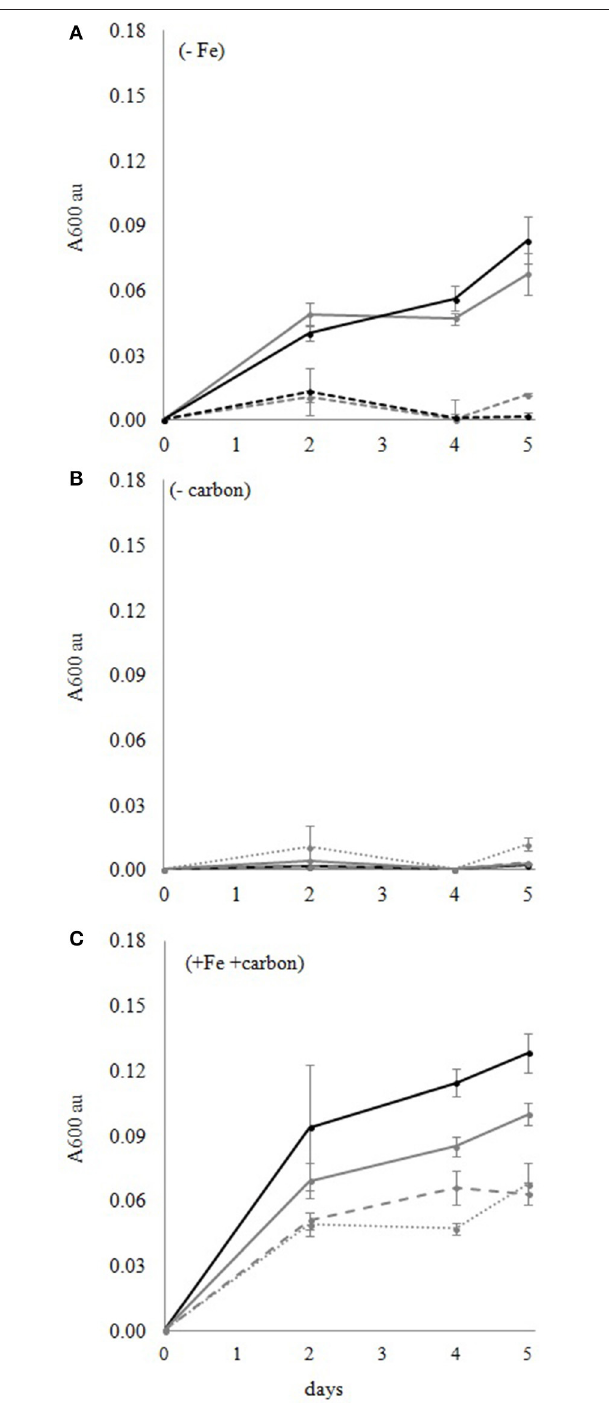
FIGURE 1 | DG893 growth in media with and without Fe and carbon. (A) DG893 growth in media without added Fe. The bold lines represent media containing 10 mg/mL Casamino Acids. The dotted lines represent media without Casamino Acids. The gray lines represent L1-Fe media. The black lines represent seawater. The VF null mutant of DG893 showed a similar pattern. (B) DG893 incubated in L1 media containing different [Fe] T but without an